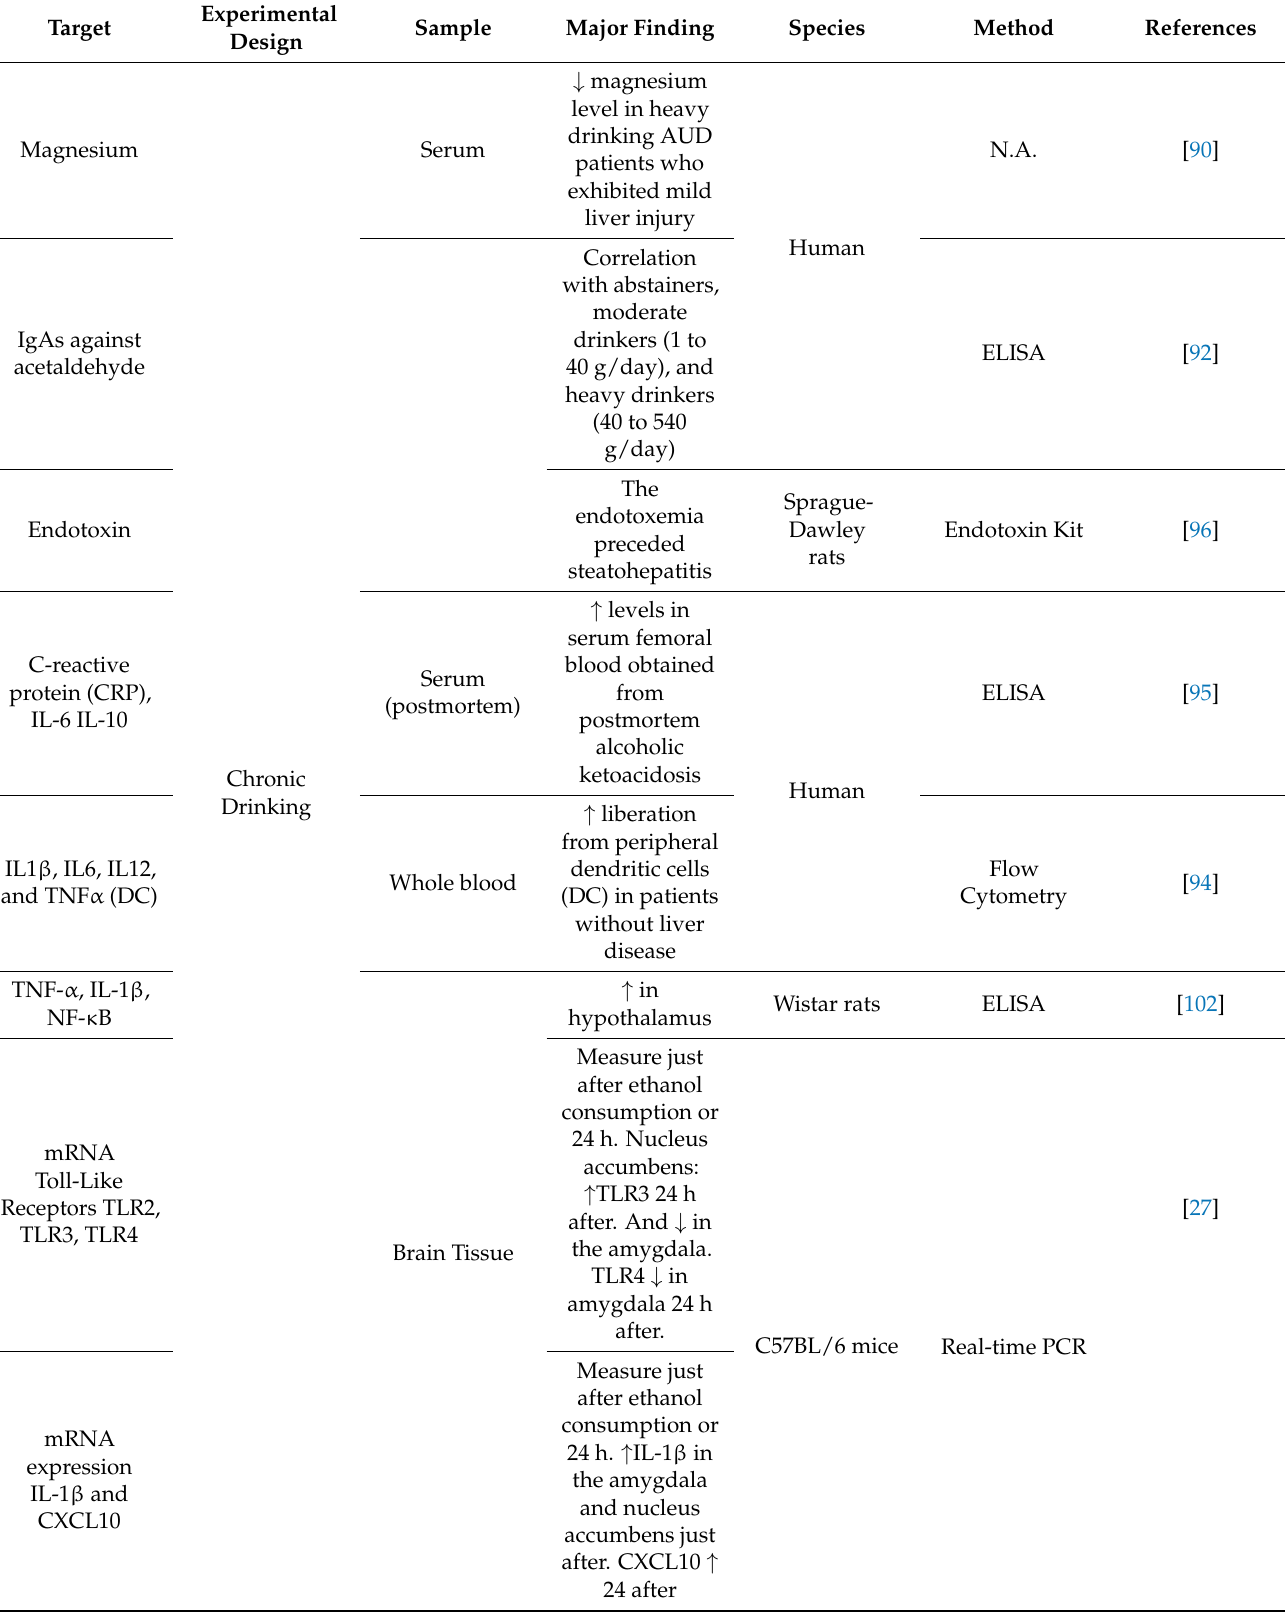
Table 3. Alcohol use disorder: Chronic